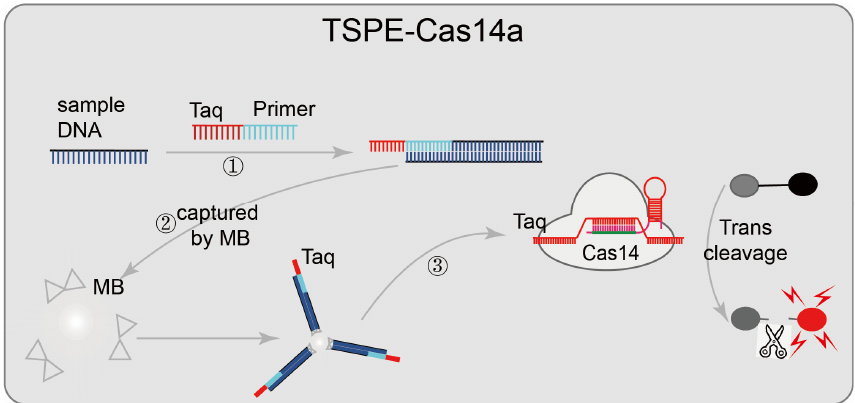
Figure 6. Applications of CRISPR/Cas14 technology: TSPE-Cas14a, designed a tag-specific primer containing two domains (primer sequence domain matching the target, and a tag sequence domain matching sgRNA); after the target sequence is matched, the primer sequence domain begins to be amplified and enriched; then the target nucleic acid is separated from the mixture using streptavidin-coated magnetic beads, and finally, matches sgRNA identifying the tag sequence domain and cleaves the fluorescence quenching reporter gene, resulting in an enhanced fluorescence signal to achieve detection.